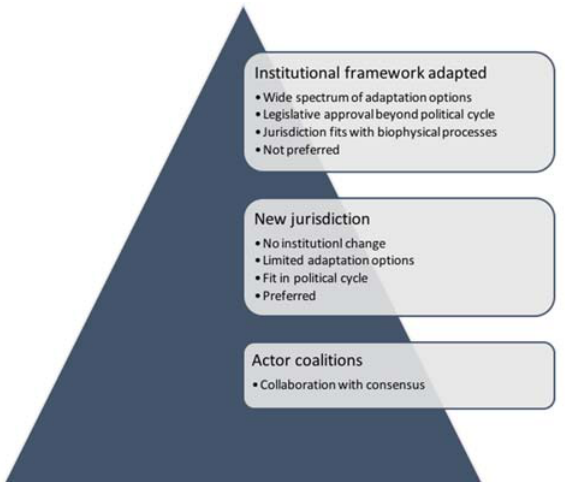
Figure 8. The hierarchical structure for the selection of adaptation measures, which depends on the preference of working with the current institutional framework.